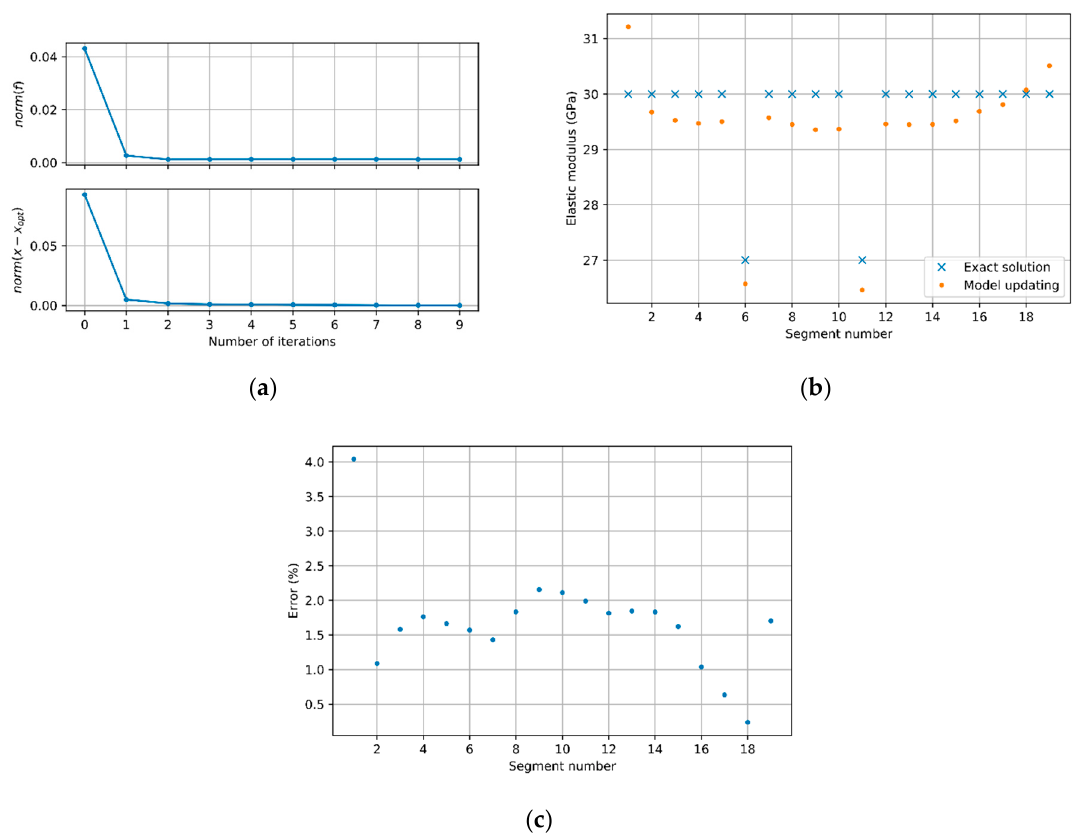
Figure 7. Model updating results: ( a ) model updating process; ( b ) comparison of elastic moduli of the structure and updated model; and ( c ) error ratio of the structure-updated model elastic moduli.